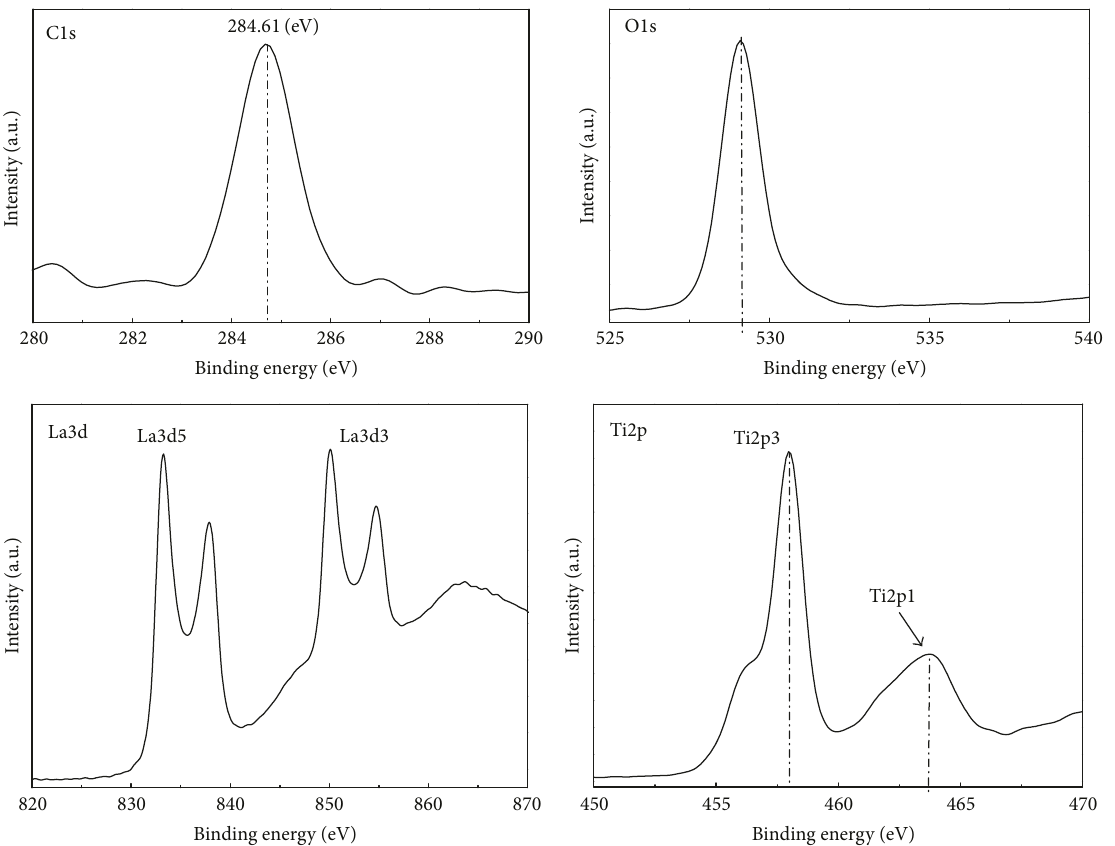
Figure 2: XPS spectra of four elements La, Ti, O, and C.